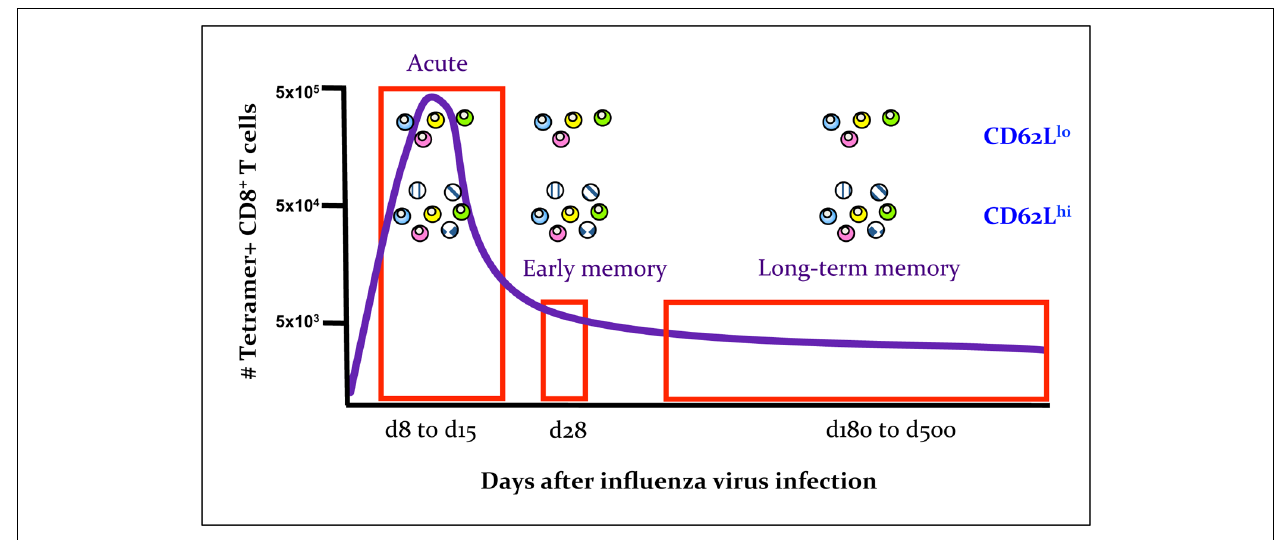
FIGURE 2 | Early establishment of a stableTCR repertoire composition for memoryT EM CD62L lo andT CM CD62L hi sets. Schematic summarizing the results ofTCR repertoire analysis of theT EM CD62L lo andT CM CD62L hi subsets for influenza-specific D b NP 366 + and D b PA 224 + CD8 + T cells at the acute phase of infection (d8–d15), early memory (d28) and late memory (d180–d500). Data are based on n = 3018 sequences published in Kedzierska etal.